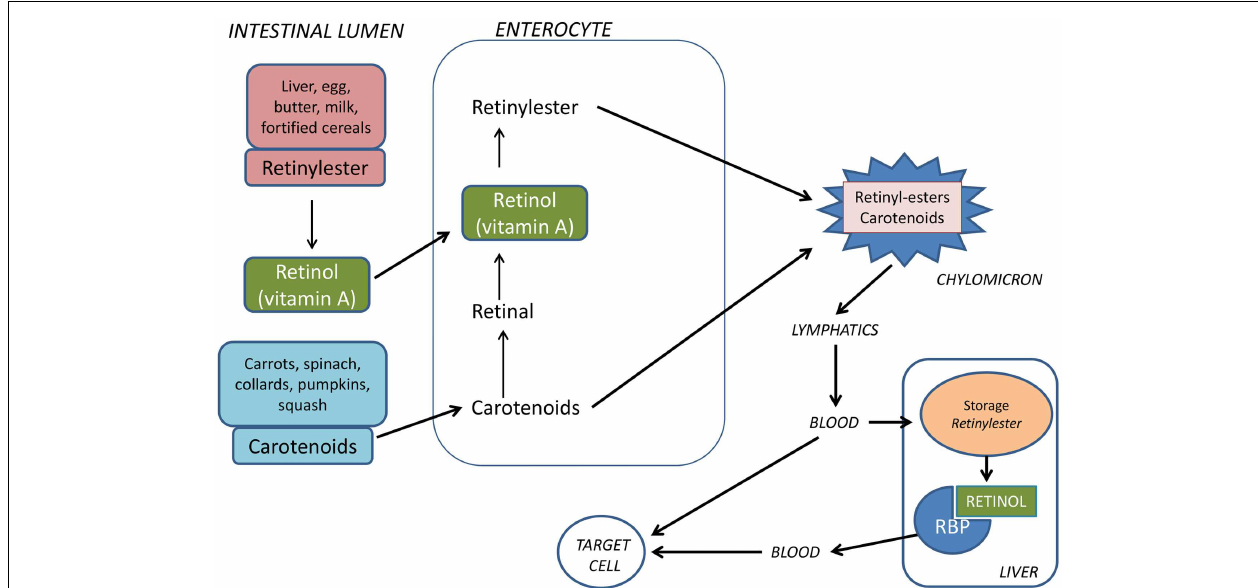
incorporated into chylomicrons together with intact carotenoids and then carried by the lymphatics.The chylomicrons are taken up by hepatocytes in the liver where vitamin A is stored as retinyl esters. Before being released from the liver to the circulation, retinyl esters are hydrolyzed to retinol which binds to retinol-binding protein